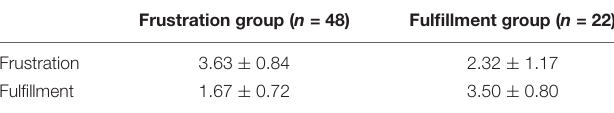
TABLE 3 | Self-reported frustration and fulfillment (Mean and